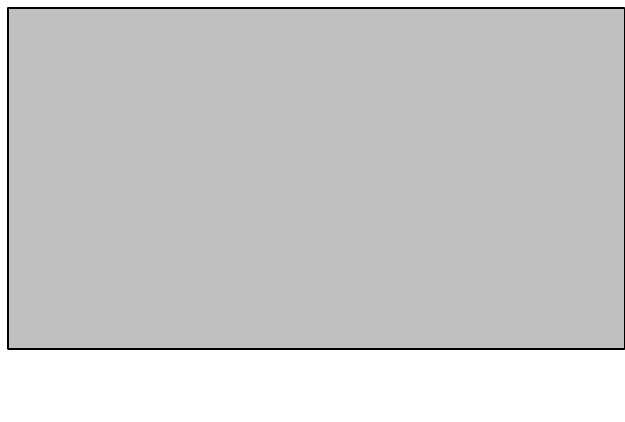
Table III : Attitudes and perception about the